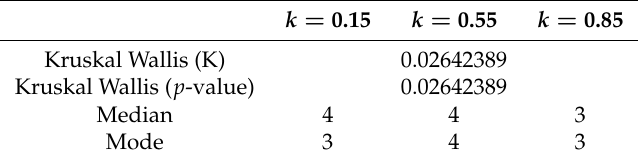
Table 3. Shows the final statistics when the users finished testing the